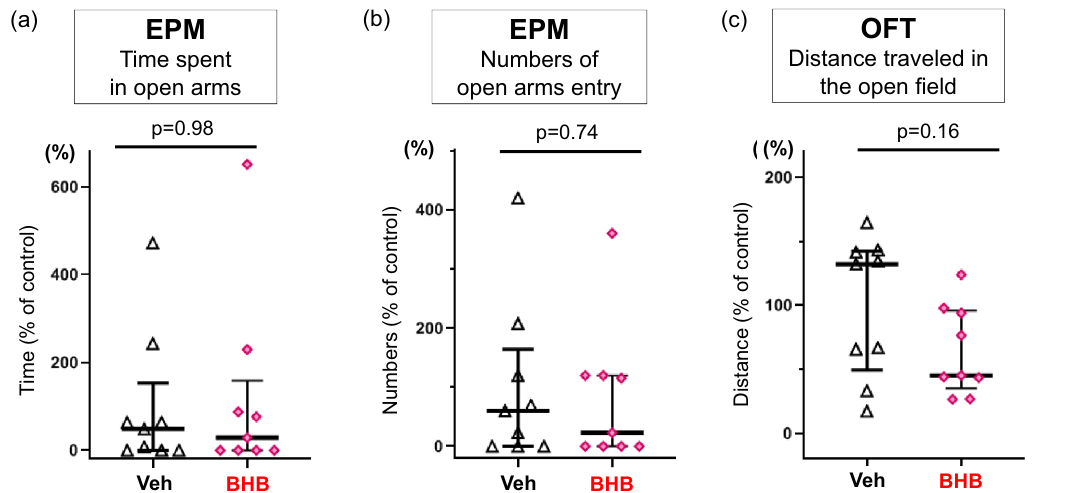
Figure 4. BHB alone does not change anxiety-like behavior or locomotor activity. ( a ) The time spent in the open arms of the EPM is shown. BHB administration did not change the time spent in the open arms